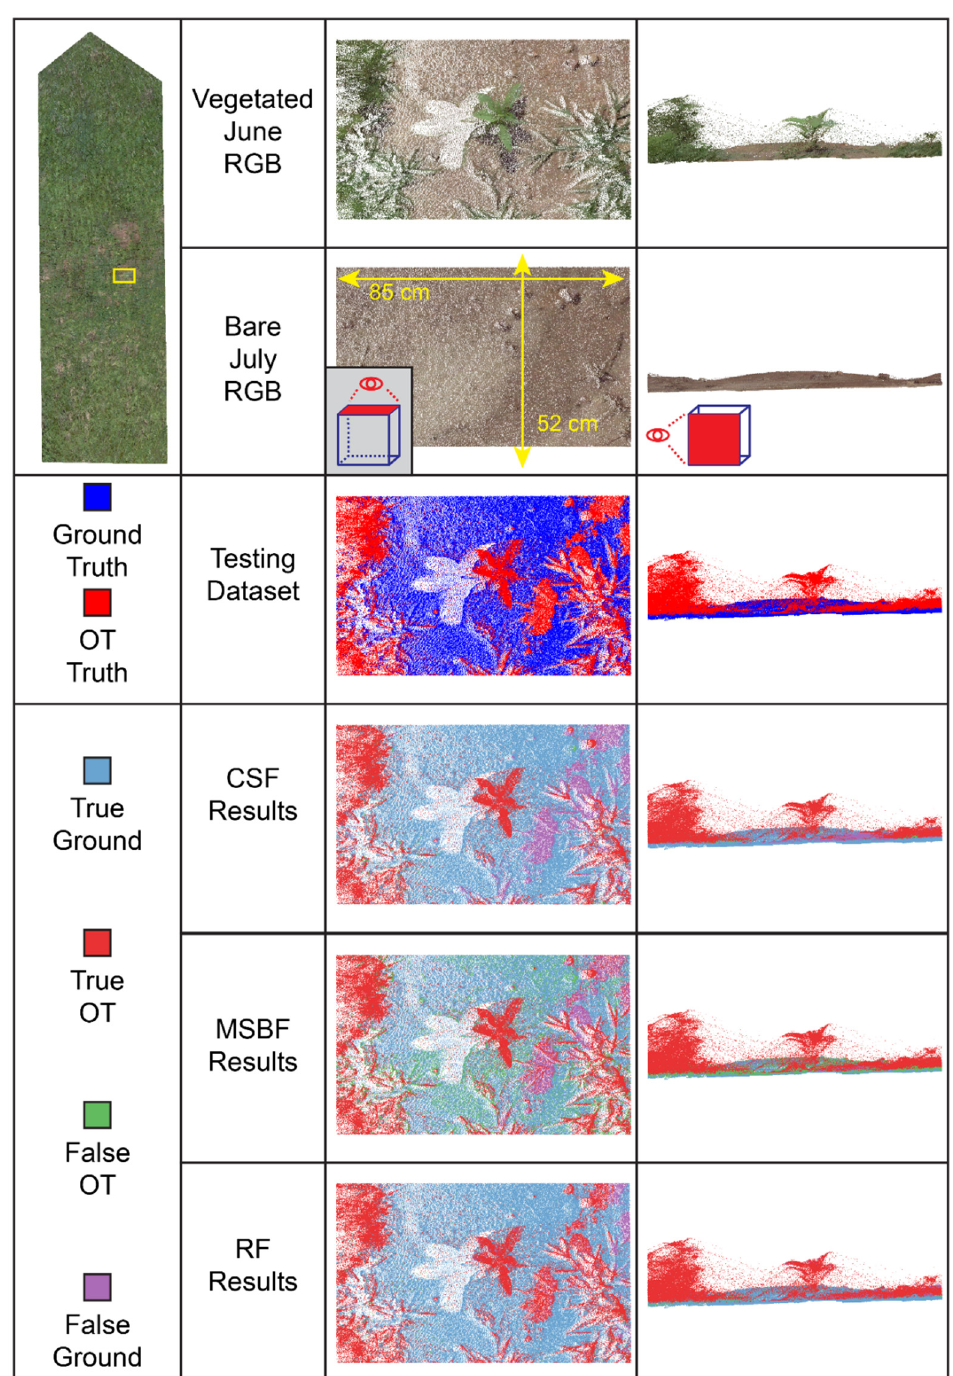
Figure 13. Filtering results on a mixed portion of the